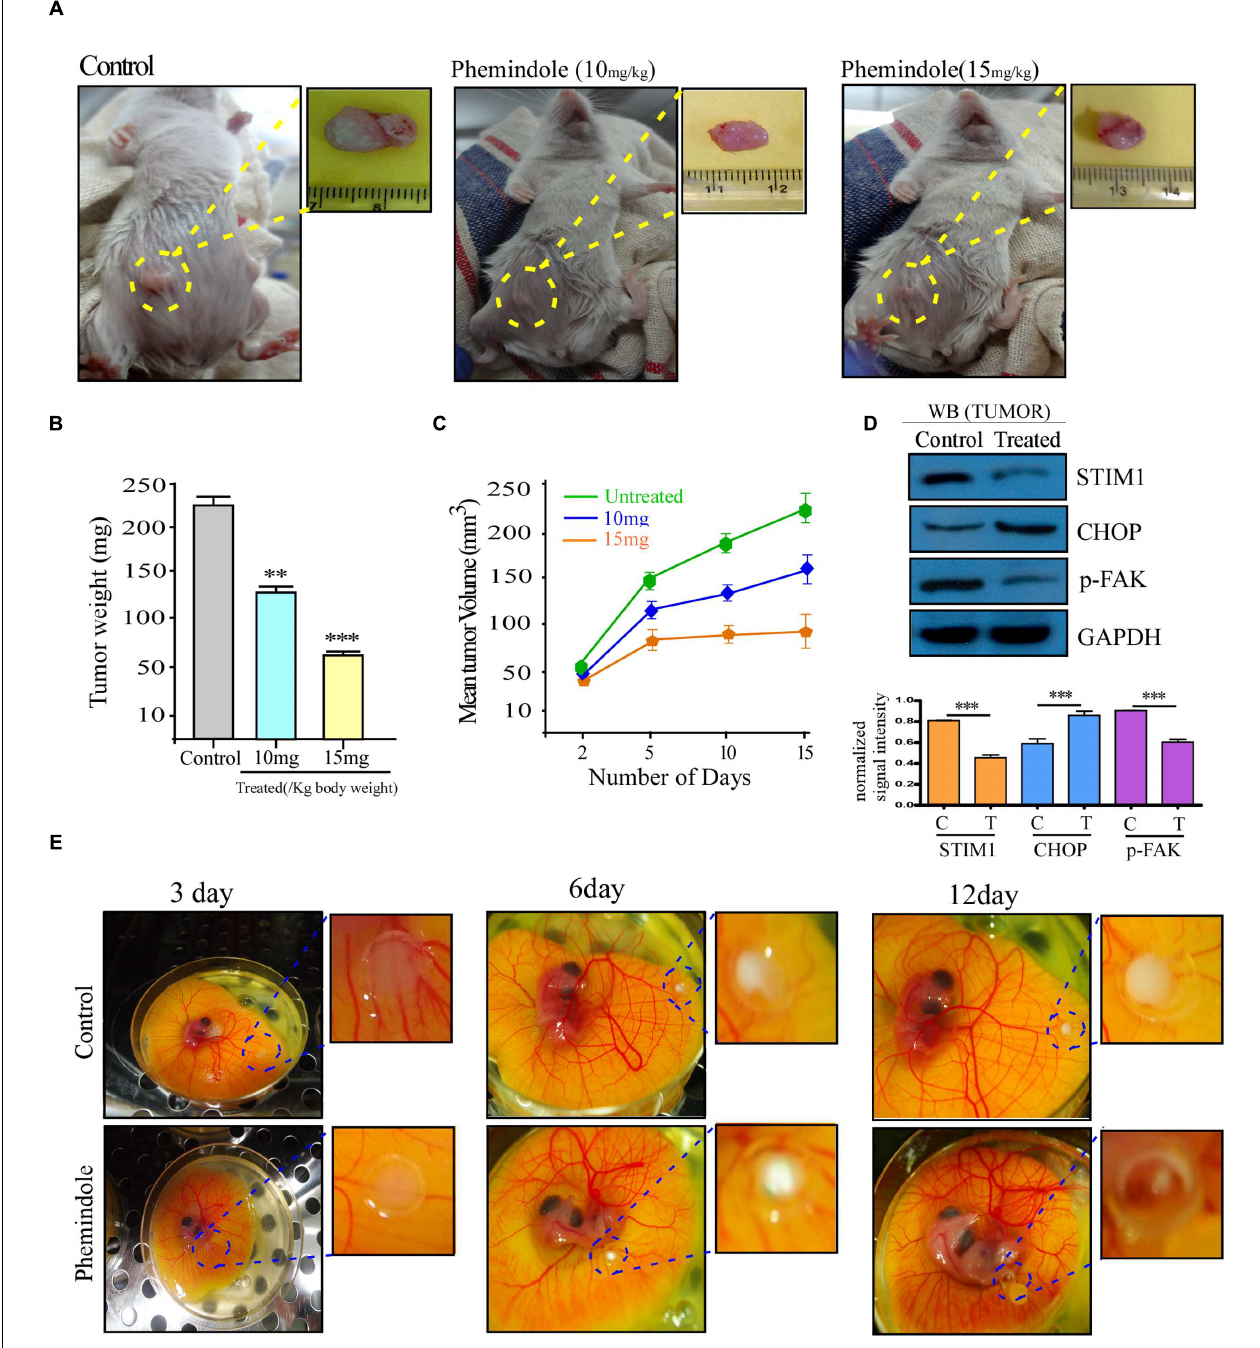
FIGURE 9 | Validation of tumor suppressive effect of Phemindole in ex ovo model and in vivo breast tumor in BALB/c mice model. (A) Photograph of 4T1 cell induced tumors from BALB/c mice and excised tumors from untreated or treated with Phemindole 10 mg/kg and 15 mg/kg body weight. (B) Weight of the excised tumors from control and Phemindole treated sets were measured, analyzed and represented in the form of bar graph. (C) Graphical representation of the changes in the tumor volume of Phemindole treated and untreated mice for a period of 8 weeks. (D) Western blot analysis depicting the changes in the expression level of different protein level in the untreated and Phemindole treated tumors. β -actin was used as internal loading control (upper panel). Blots are representative of three independent experiments and quantifications are indicated by Bar diagram (lower panel). Values were normalized by intensity of loading control. (E) Ex ovo model showing tumor regression due to Phemindole treatment at 3, 6, and 12 days. Values are mean ± SEM of three independent experiments in each case or representative of typical experiment. ∗∗ P < 0.01, and ∗∗∗ P < 0.001.